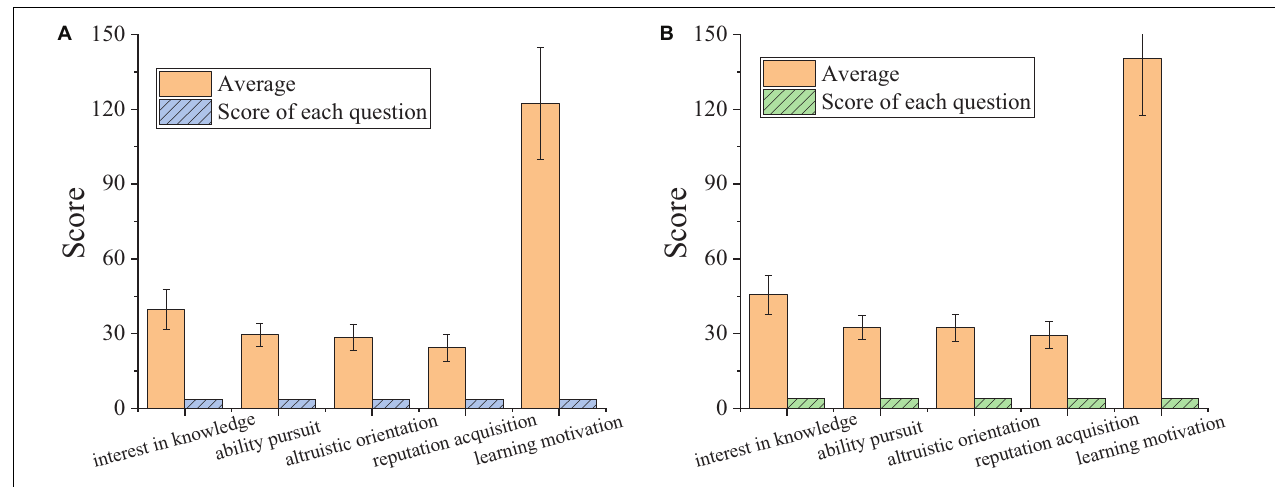
FIGURE 5 | Descriptive statistics for the learning motivation of Chinese and Malaysian college students majoring in sports. (A) Sport School of Zhengzhou University. (B) Center for Sport and Exercise Science University of Malaya.